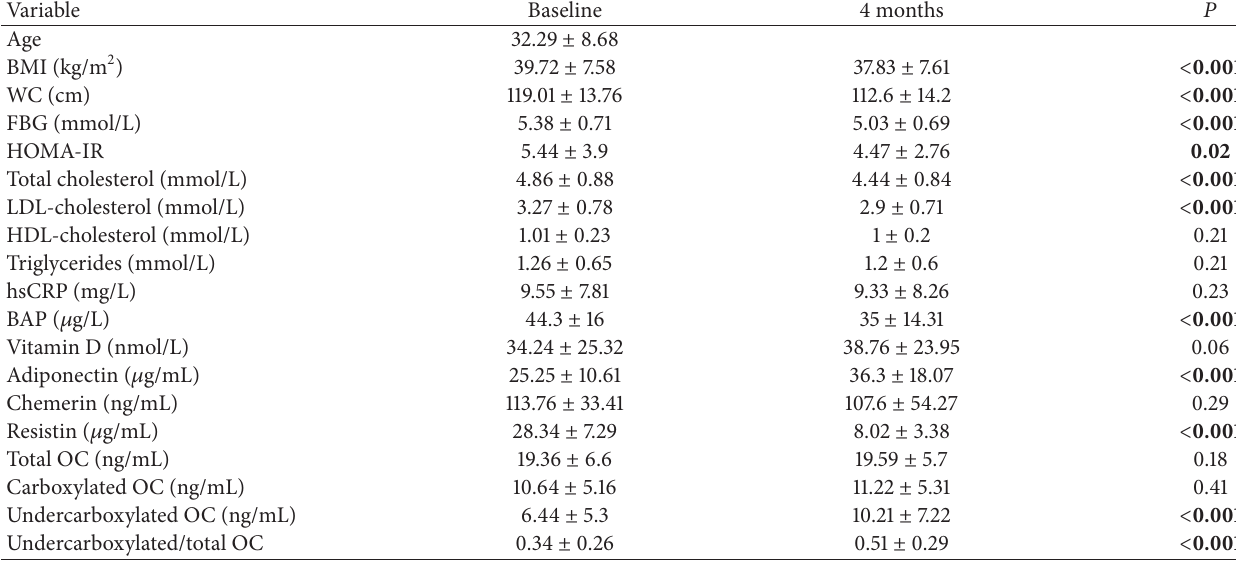
Table 1: Change in clinical and metabolic characteristics 4 months after weight loss ( 𝑛 =